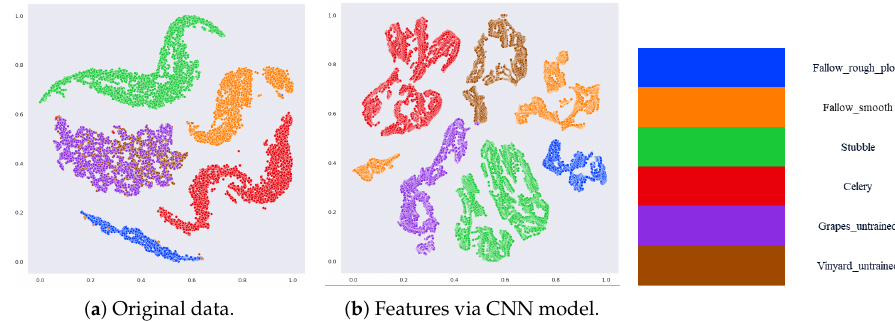
Figure 14. Visualization of the data points of the Salinas dataset. Using t-SNE, we reduced the feature dimensionality to 2.